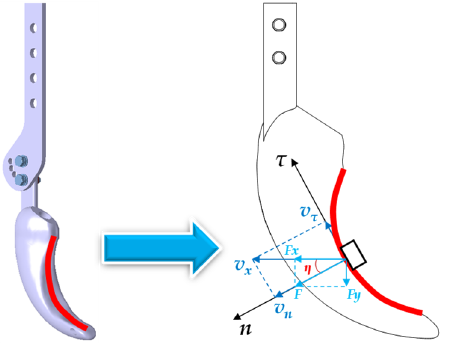
Figure 11. Kinetic analysis of the interaction between the bionic liquid fertilizer deep application spray needle surface and soil